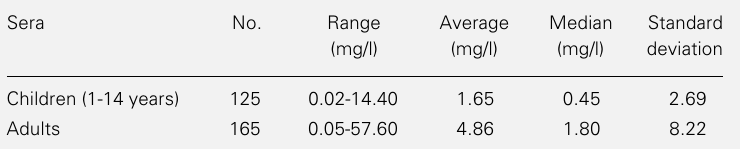
Table 1 - CRP levels in human sera as determined by ELISA.